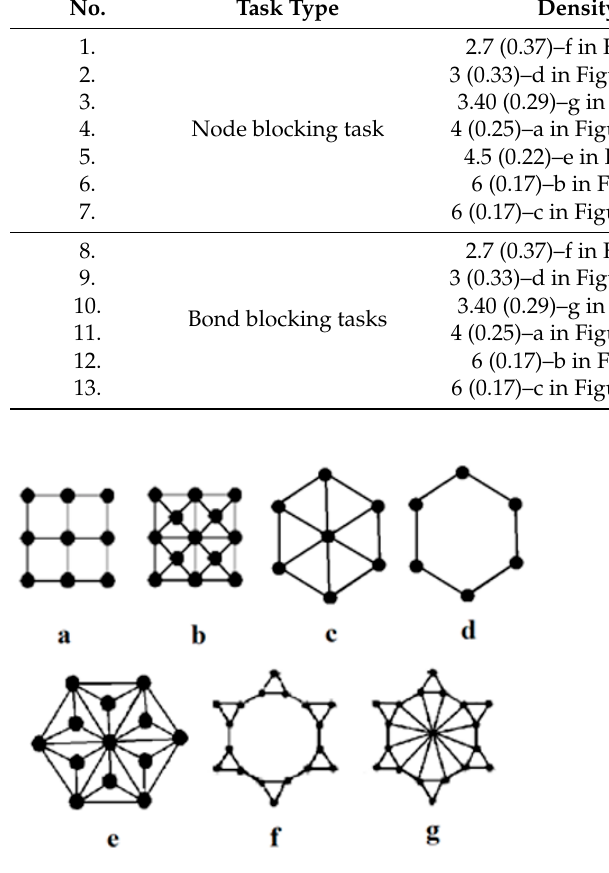
Figure 7. Geometrical representation of some regular network structures ( a – g ).